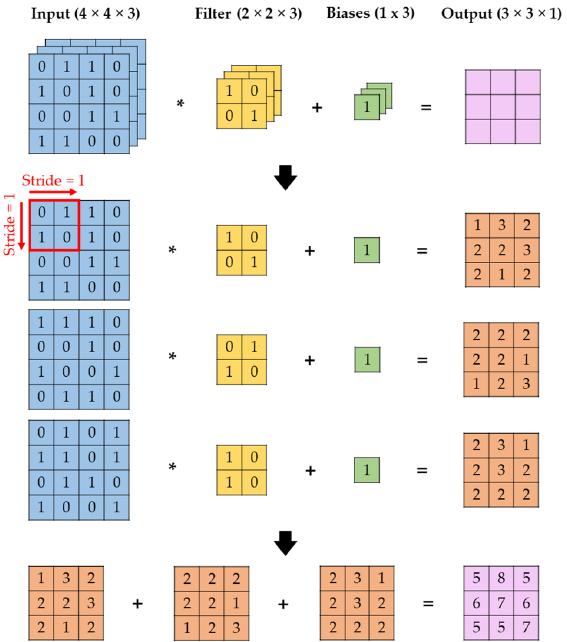
Figure 10. Convolution for multi-channel inputs.